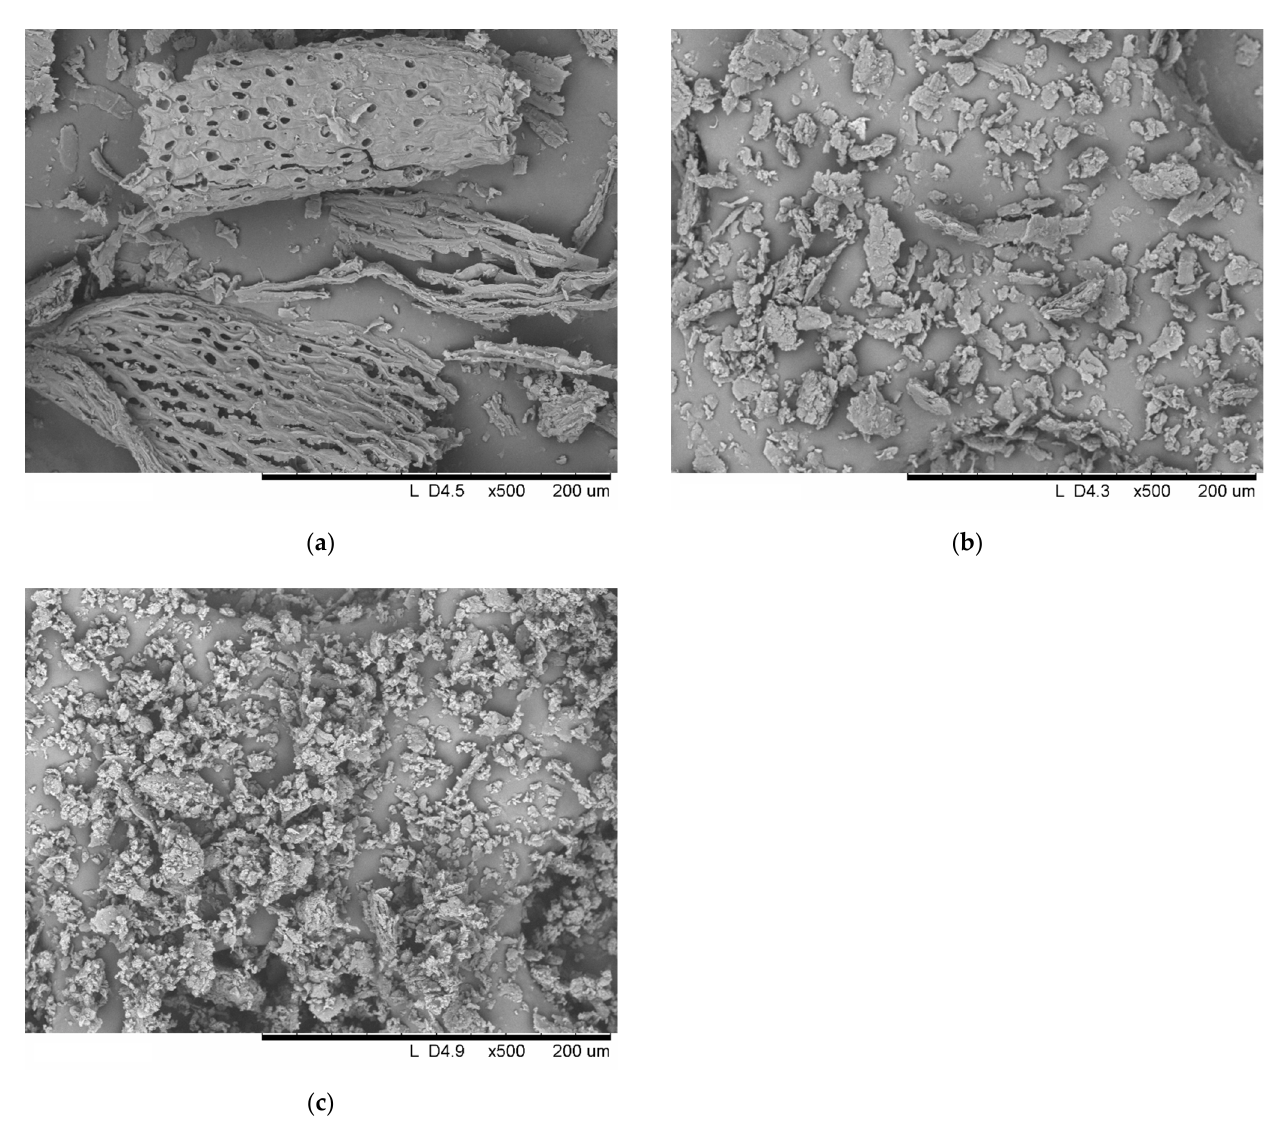
Figure 1. SEM images of natural peat ( a ), mechanically activated peat ( b ), mechanochemically activated peat ( c ).